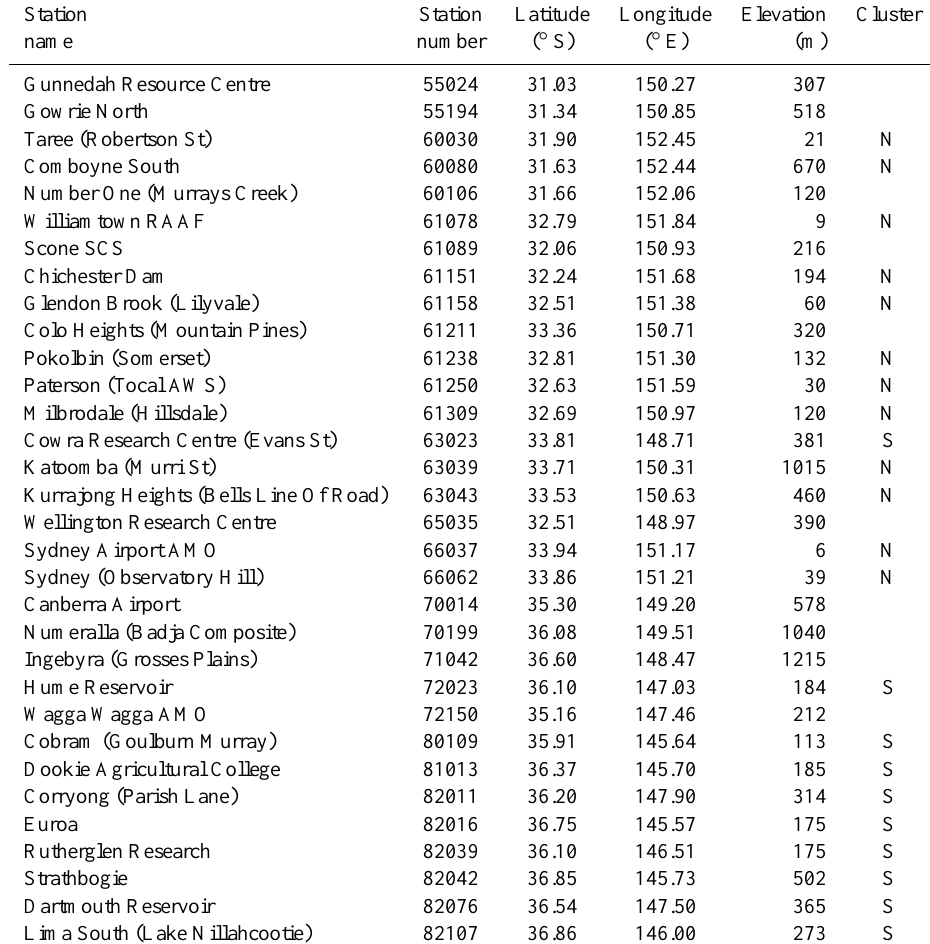
Table 1. Station details for a set of sites with suitable data for the period 1976–2005. Last column indicates cluster membership (discussed in Sect. 3.2). “N” denotes “north cluster”, “S” denotes “south cluster”.